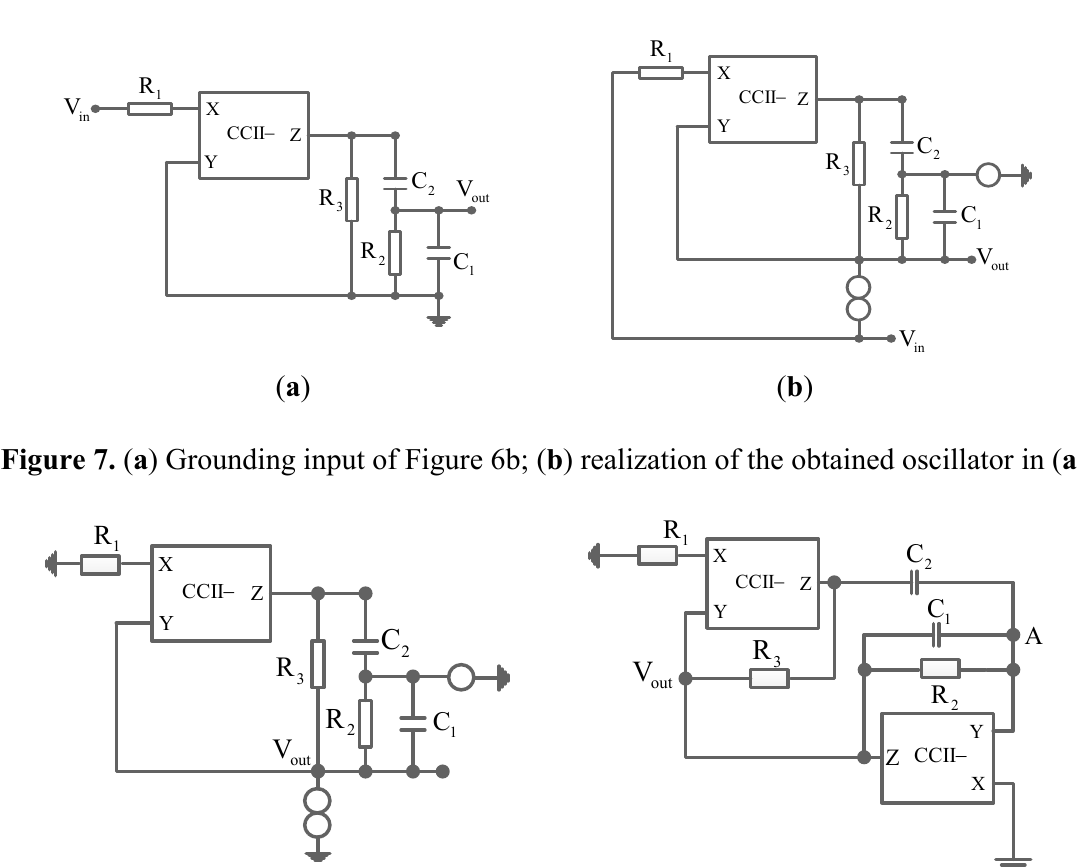
Figure 6. ( a ) A CCII-based band pass filter; ( b ) the obtained filter after applying the transformations in Table 2.